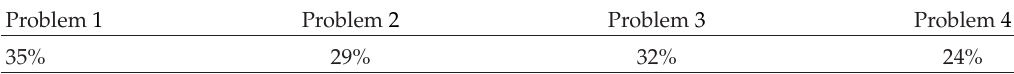
Table 7: Average percentage of the coarse-tuning stage of the four problems.